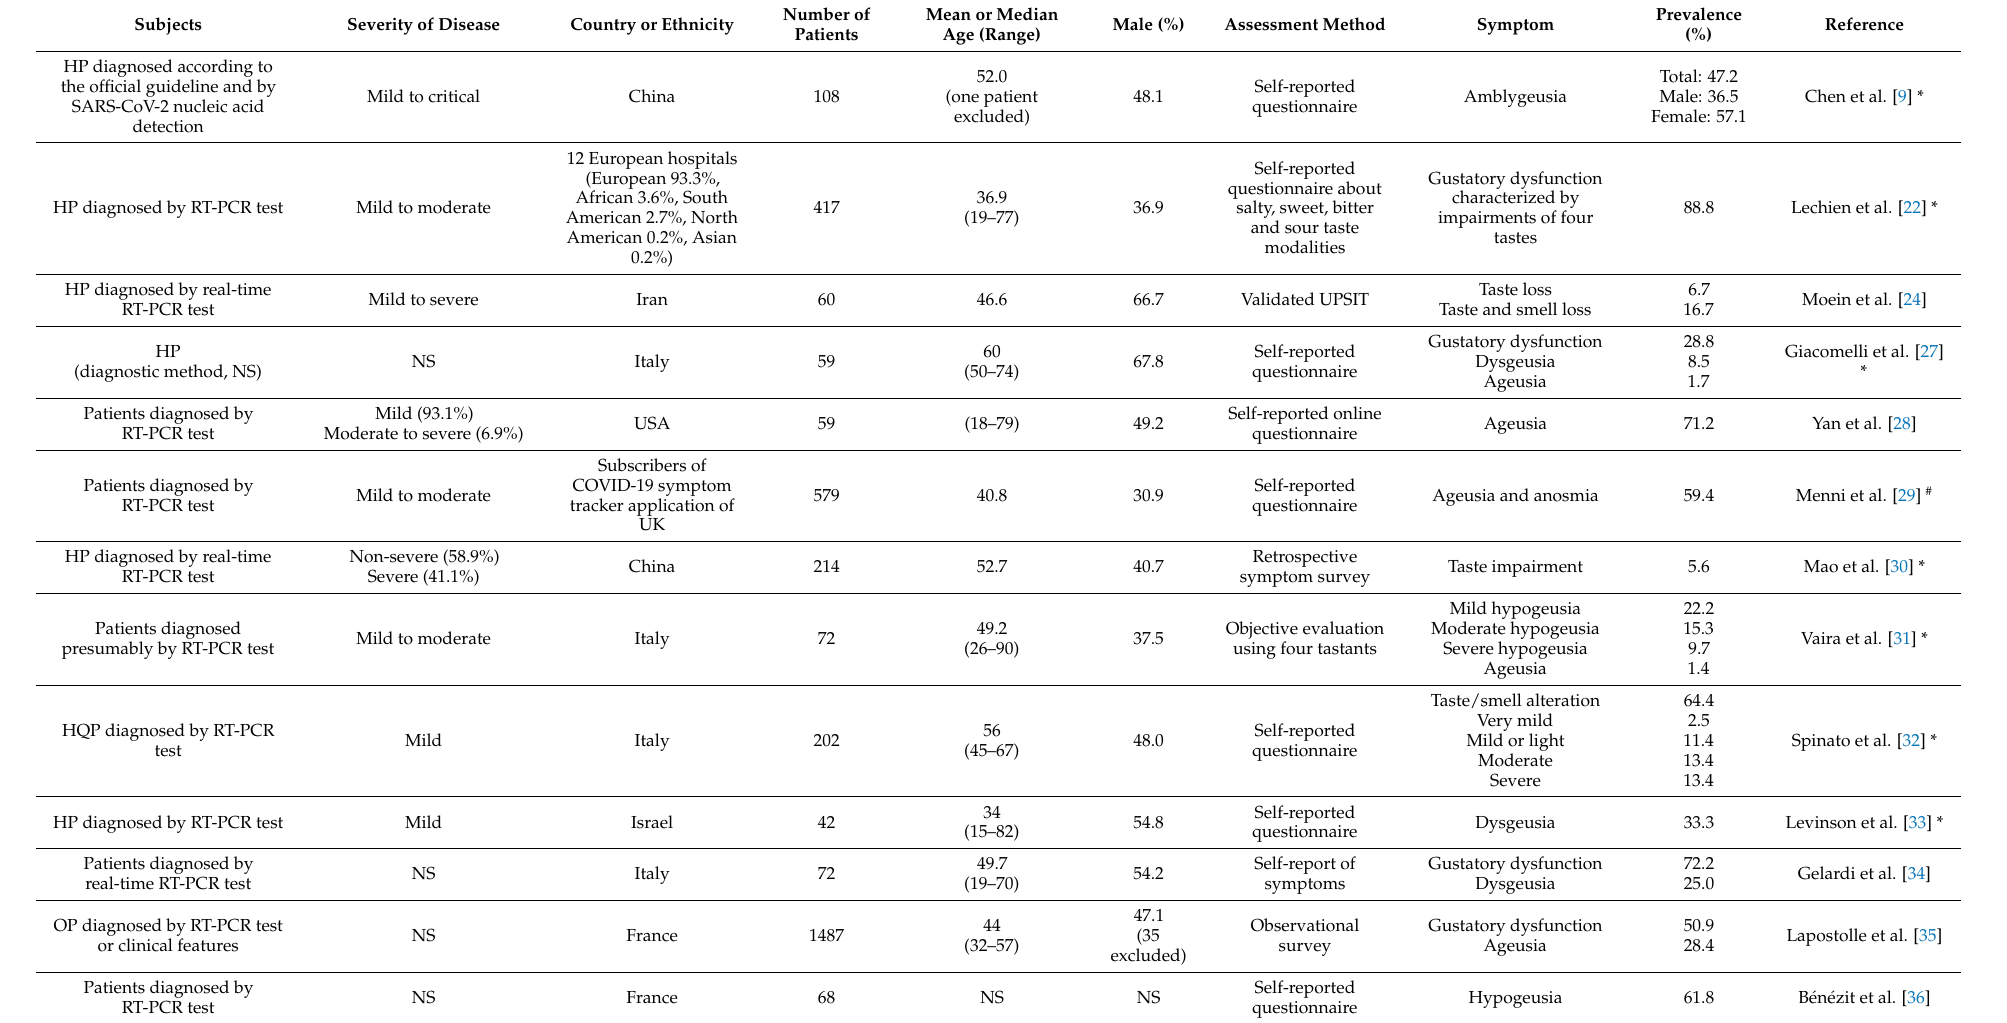
Table 1. Gustatory dysfunction associated with coronavirus disease 2019